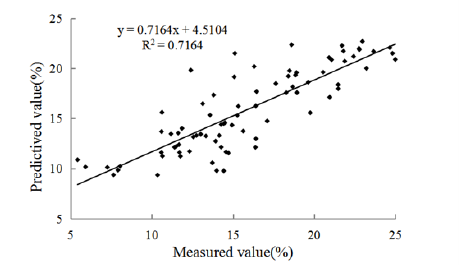
Figure 9. Estimated result of RBF-NN Table 3. Estimation accuracy comparison table of